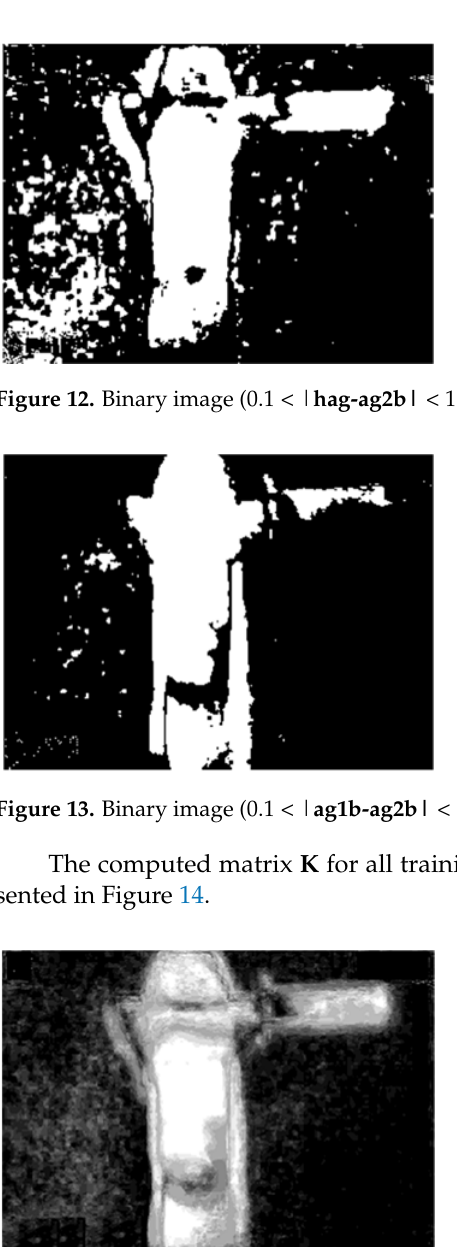
Figure 14. Computed matrix K for all training thermal images.